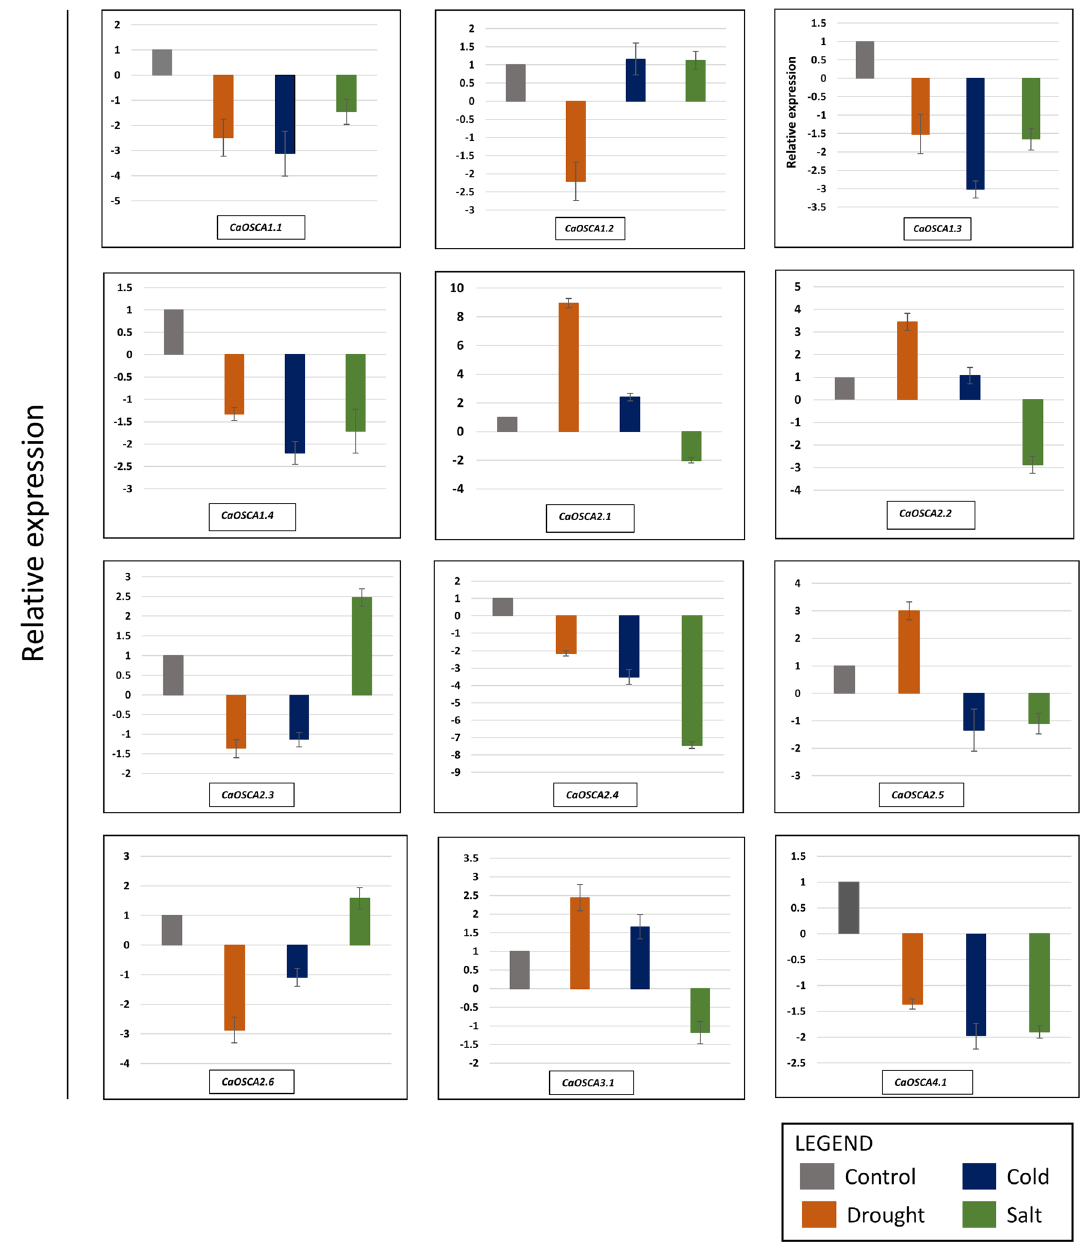
Figure 7. Bar plot showing expression of OSCA genes under desiccation (orange), cold (dark blue), and salt (green). Control is shown in grey. Y- axis depicts relative expression. Results are obtained from qRT-PCR